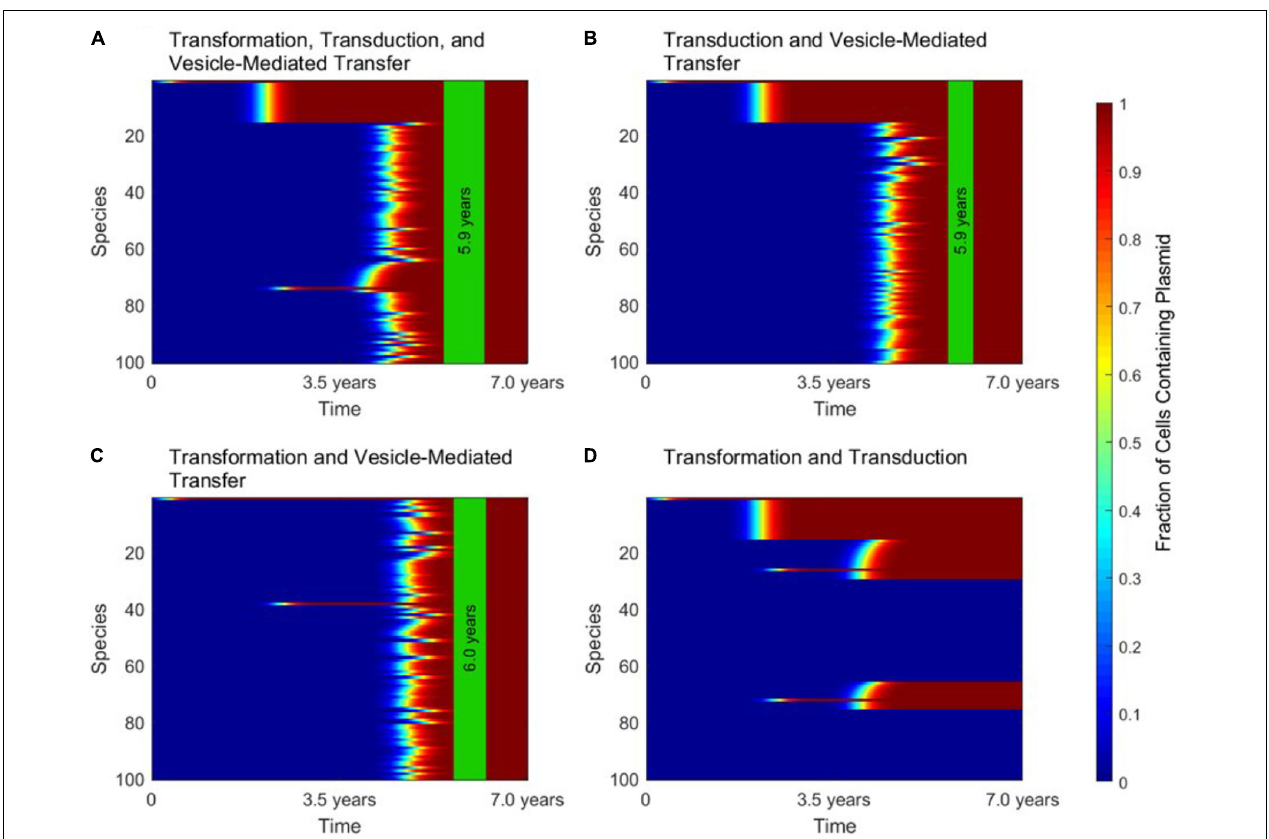
FIGURE 4 | The roles of transformation, transduction, and vesicle-mediated transfer in horizontal gene transfer. For all four panels, conjugation did not occur, as in the case of a non-conjugative, non-mobilizable plasmid. In each panel, the vertical green stripe marks the mean time that the plasmid achieved full spread, plus and minus one standard deviation, for 5 repetitions of the simulation. Each plot shows uptake results for a single run. Full spread is defined as 99% plasmid uptake in every bacterial species. (A) For a simulation with transformation, transduction, and vesicle-mediated transfer, full spread occurred after 5.9 ± 0.4 years. (B) In a simulation without transformation, full spread occurred after 5.9 ± 0.2 years. (C) In a simulation without transduction, full spread occurred after 6.0 ± 0.3 years. (D) In a simulation without vesicle-mediated transfer, full spread was not achieved. The simulation terminated after 7.0 years, but full spread would never have